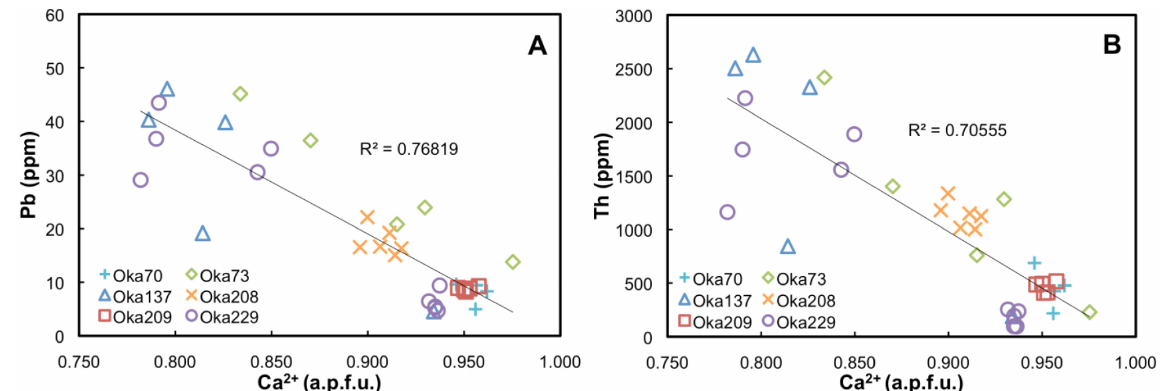
Figure 7. Plots exhibiting the correlations between Pb ( A ) and Th ( B ) abundances vs. Ca 2+ (a.p.f.u.) for perovskite from Oka.